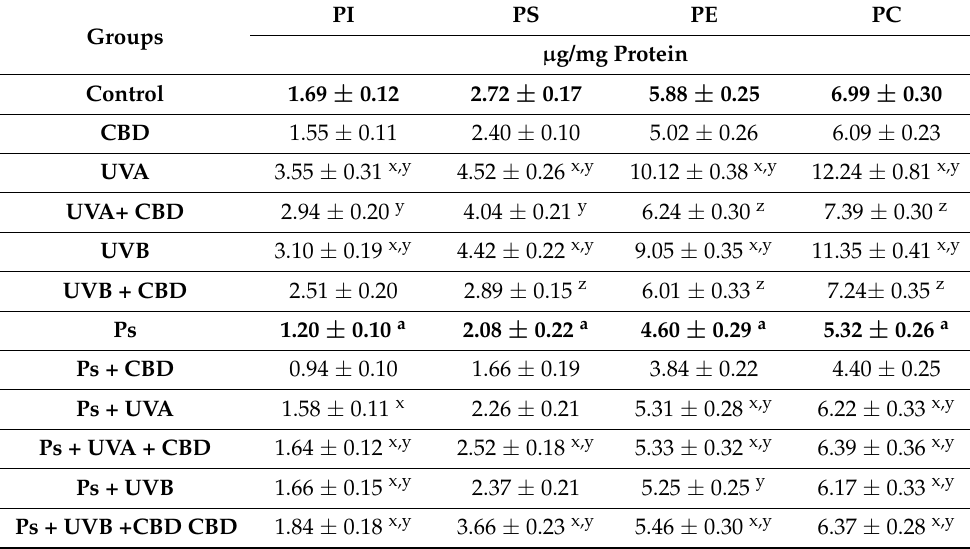
Table 2. Phospholipids membrane composition of fibroblasts isolated from skin of healthy subjects (Ctr) ( n = 6) and psoriatic patients (Ps) ( n = 6) exposed to UVA (30 J/cm 2 ) and UVB (60 mJ/cm 2 ) radiation as well as untreated and treated with CBD (4 µ M). The mean values ± SD and statistically significant differences for p < 0.05 are